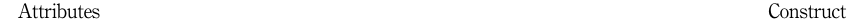
Table I. Categorization of the attributes of mobile learning into